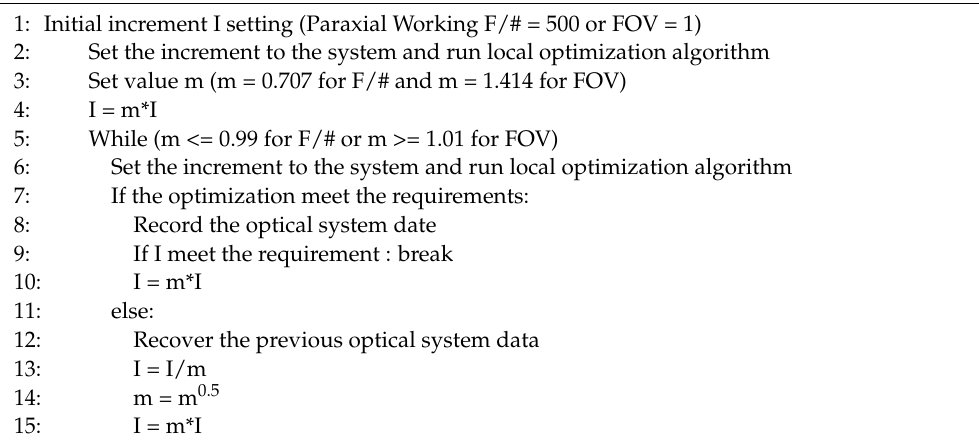
Algorithm 1. The algorithm of the aperture stop or FOV size increment.